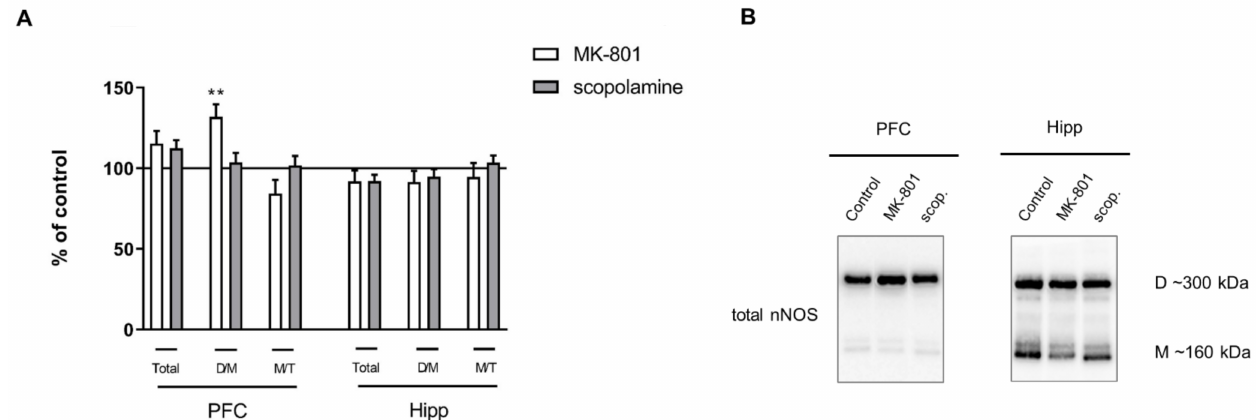
Figure 4. nNOS expression in the prefrontal cortex (PFC) and hippocampus (Hipp) after acute administration of MK-801 (0.3 mg/kg) or scopolamine (1 mg/kg) ( A ). Representative Western blots ( B ). D/M—dimer/monomer ratio; M/T—monomer/total ratio. Data are presented as means ± SEM. ** p < 0.01 vs. control.